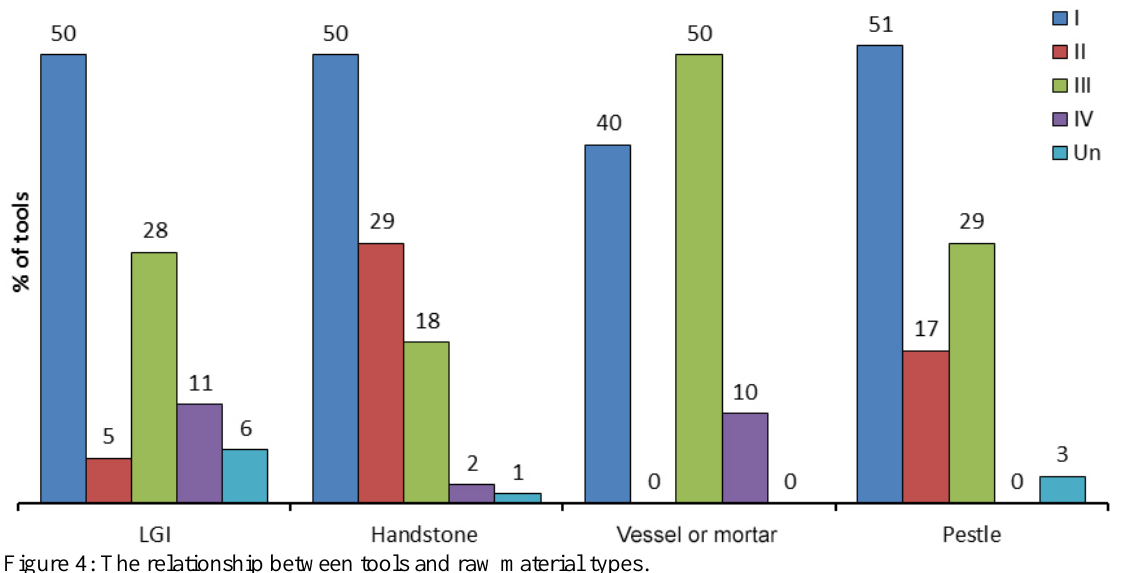
Figure 4: The relationship between tools and raw material